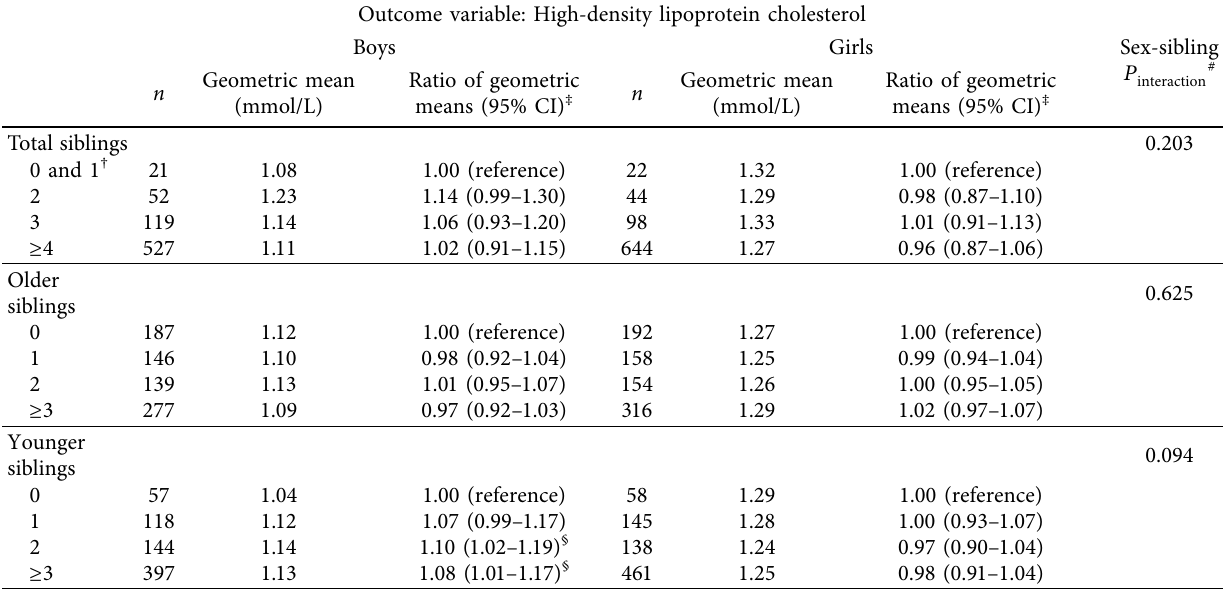
Table 4: Geometric means and adjusted ratio of geometric means of high-density lipoprotein cholesterol according to the total number of siblings, number of older siblings, and number of younger siblings stratified by sex.